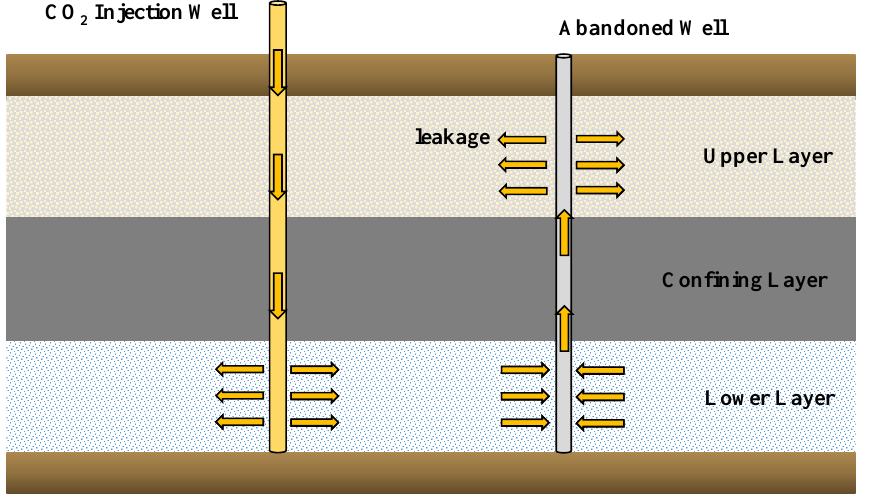
Figure 1. Schematic of the CO 2 storage site, where the leakage problem consisting of a CO 2 injection well into the storage site and an abandoned well leaking with hydraulic conductivity to an upper geological